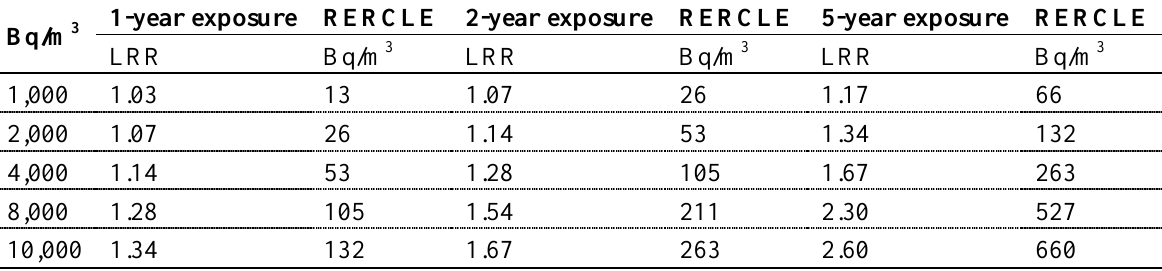
Table 1. Risk equivalent radon concentration for lifetime exposure (RERCLE) when Canadian boys are exposed to radon concentrations of 1,000, 2,000, 4,000, 8,000, and 10,000 Bq/m 3 for short periods of 1, 2 and 5 years.